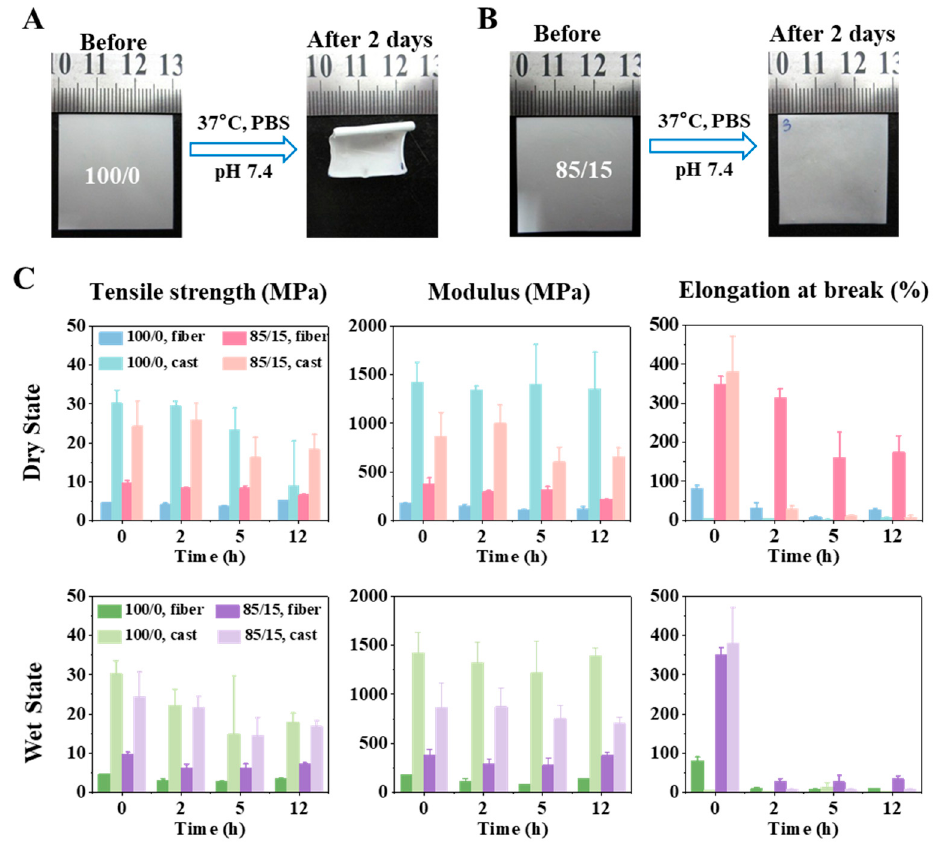
Figure 3. Morphological stability and mechanical performance of fibrous membrane. The macro morphological change before and after swelling in PBS of 100/0 ( A ) and 85/15 ( B ) electrospun membranes. ( C ) Tensile strength ( left ), modulus ( middle ), and elongation at break ( right ) of 100/0 and 85/15 membranes (fibrous membranes and cast films) in a dry state ( top ) and wet state ( bottom ).